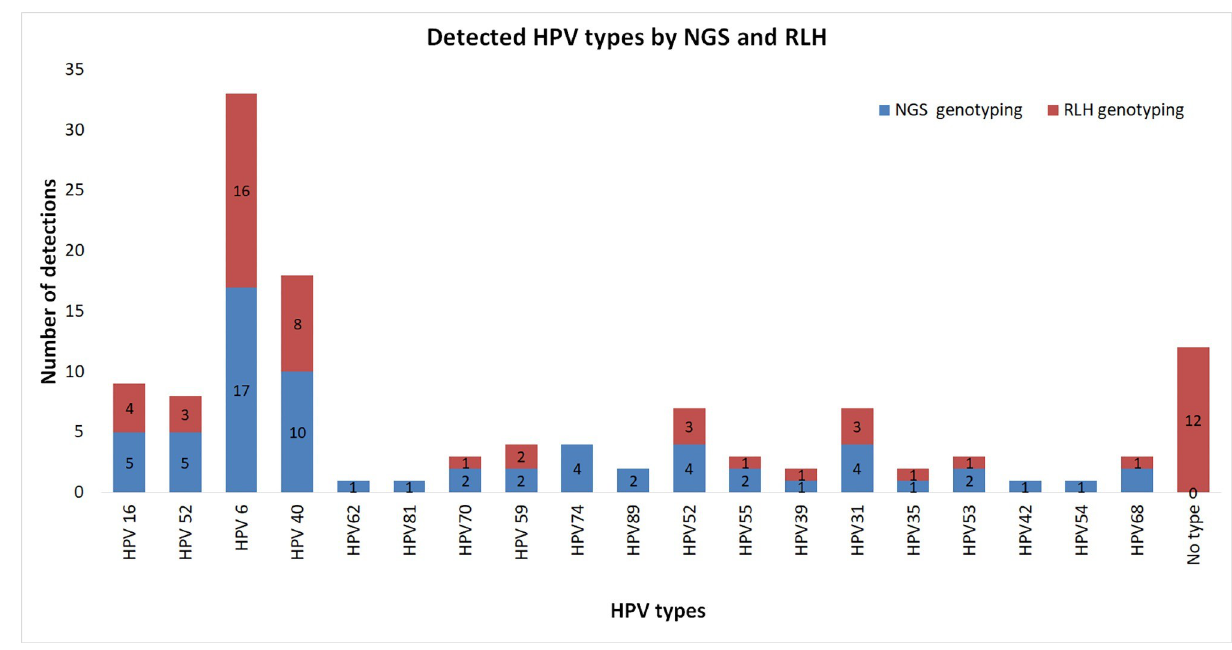
Fig 4. Detected HPV types by NGS and comparison with RLH.